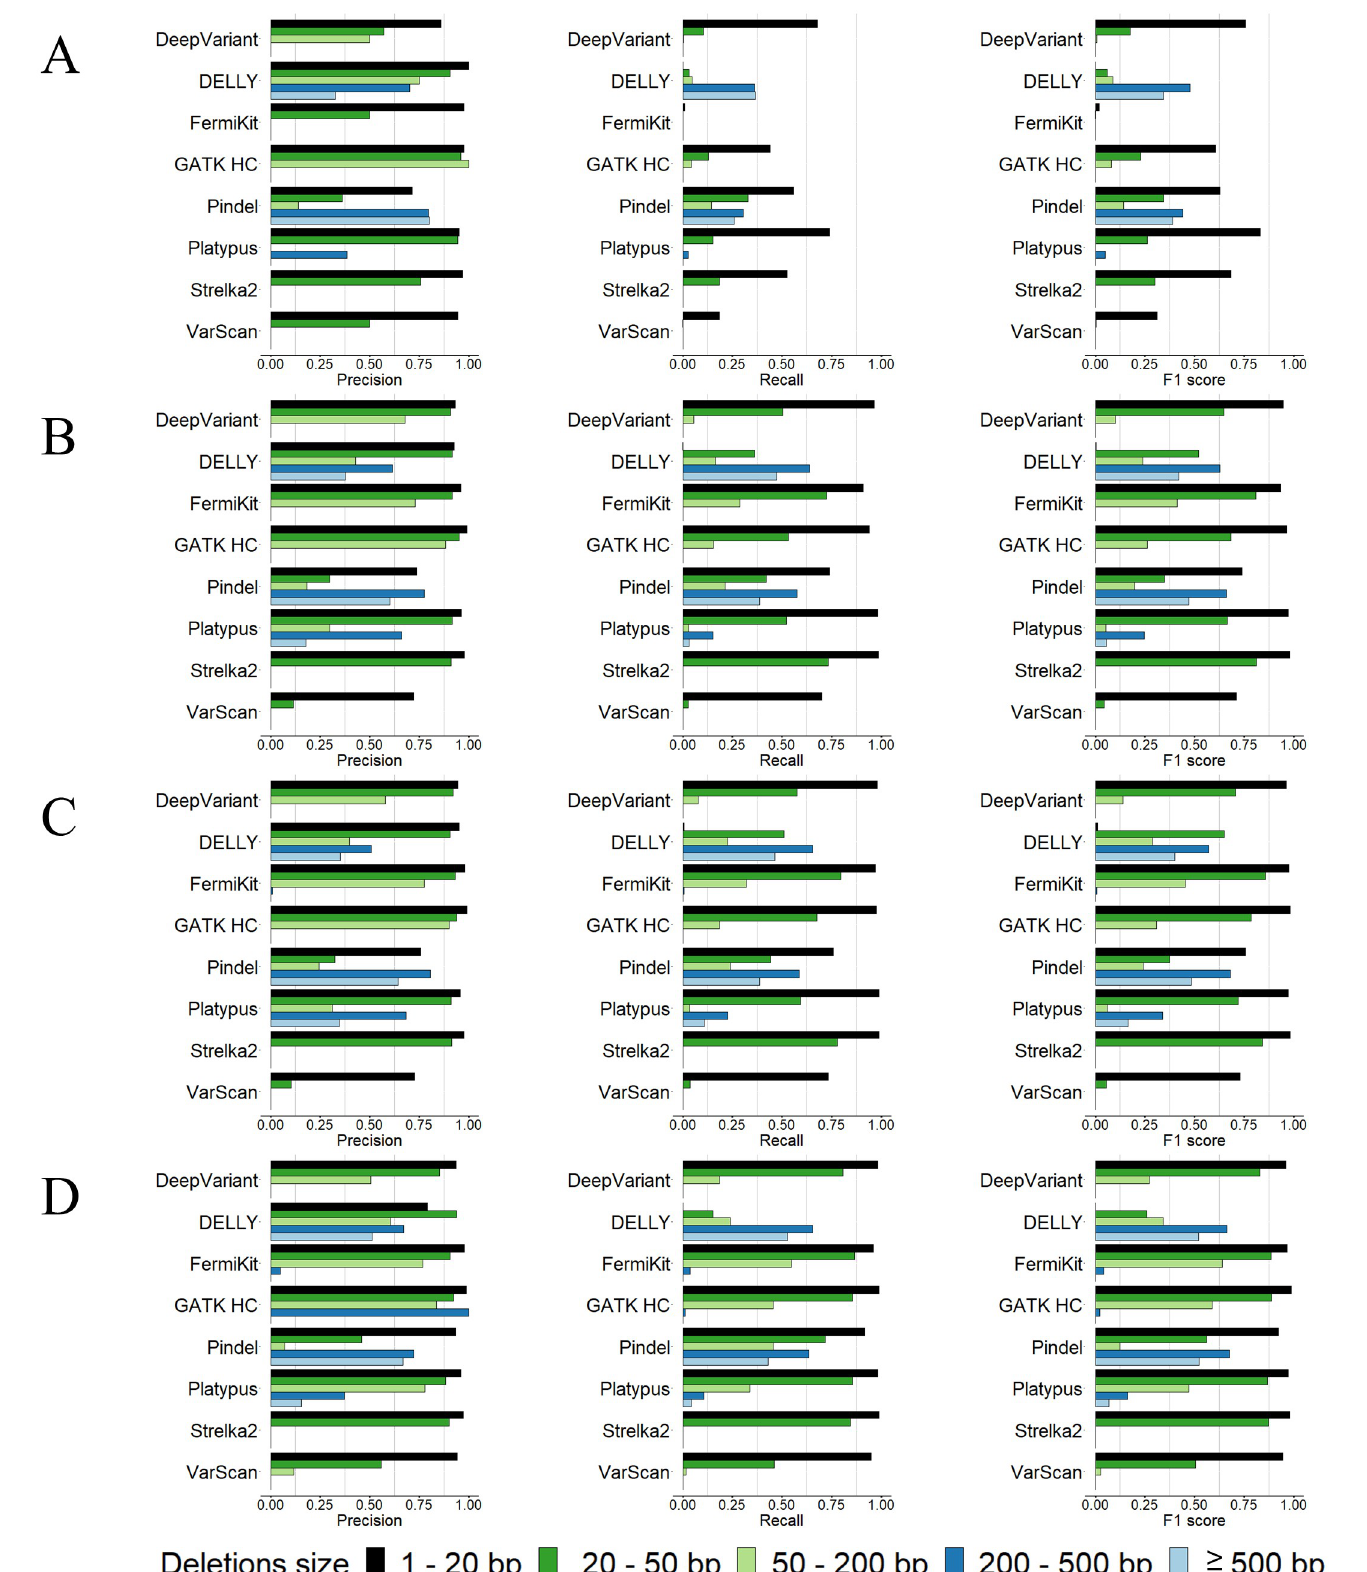
Fig 1. Precision rates, recall rates and F1 scores for tools’ deletion calling using the semi-simulated datasets. (A) 5 × coverage, 100bp read length sequencing data. (B) 30 × coverage, 100bp read length sequencing data. (C) 60 × coverage, 100bp read length sequencing data. (D) 30 × coverage, 250bp read length sequencing data. https://doi.org/10.1371/journal.pcbi.1009269.g001 PLOS Computational Biology | https://doi.org/10.1371/journal.pcbi.1009269 February17, 2022 10 /